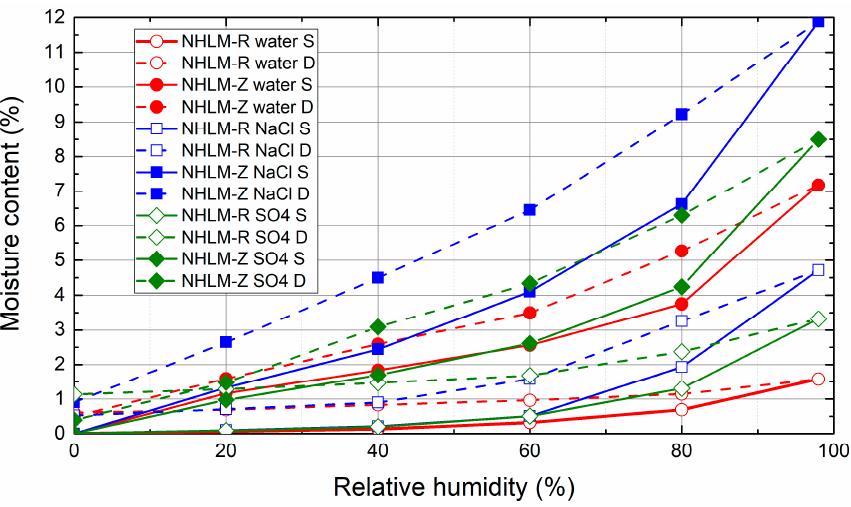
Figure 10. Sorption and desorption isotherms of natural hydraulic lime mortars (NHL).